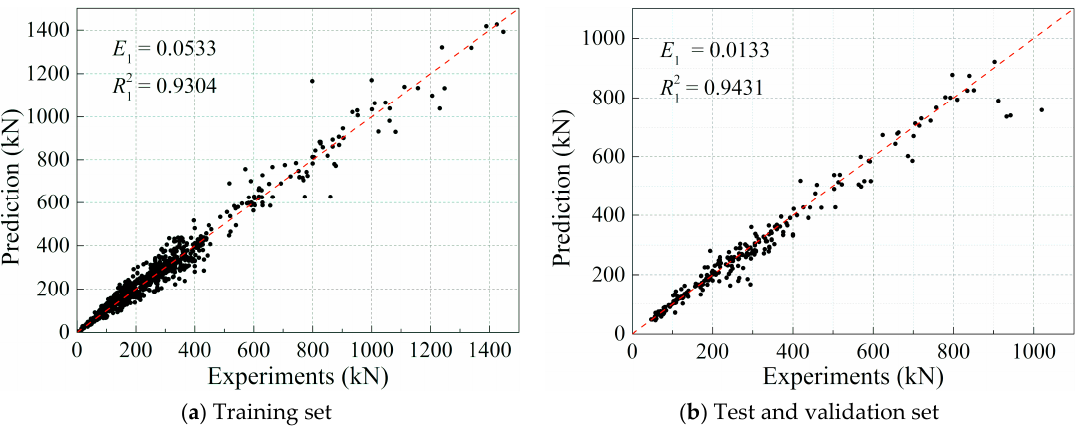
Figure 6. Comparison of experimental results and predicted results of the strength of RC columns.